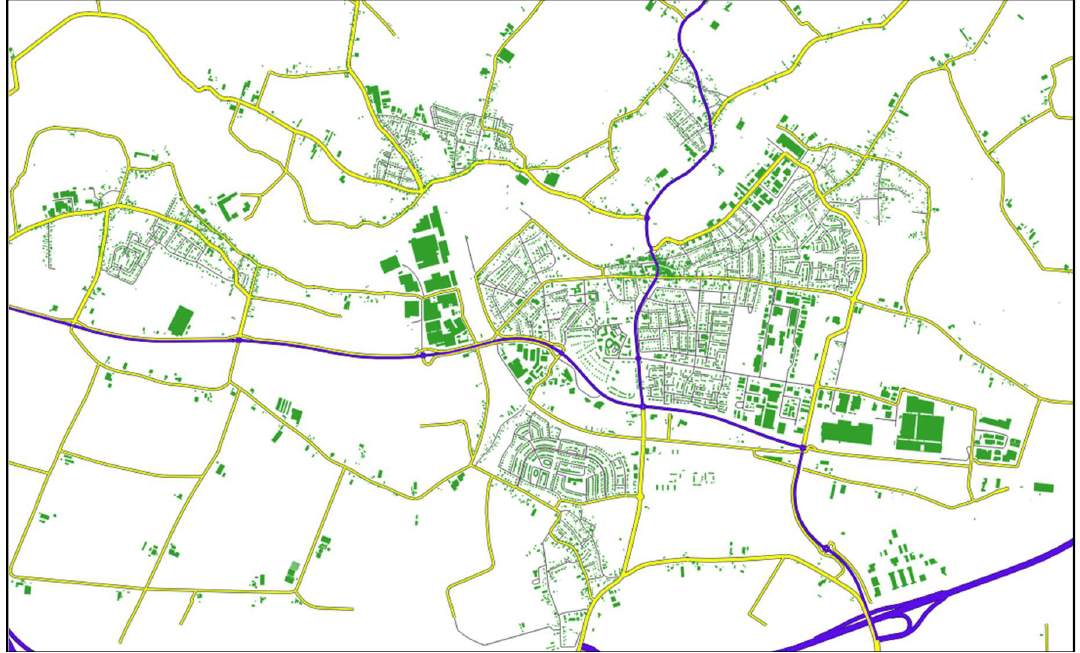
Figure 10. Sample area of our datasets (Geldermalsen, NL) consisting of city centers, urban, suburban, rural, and industrial/commercial regions. For clarity, only OSM buildings are shown in green.